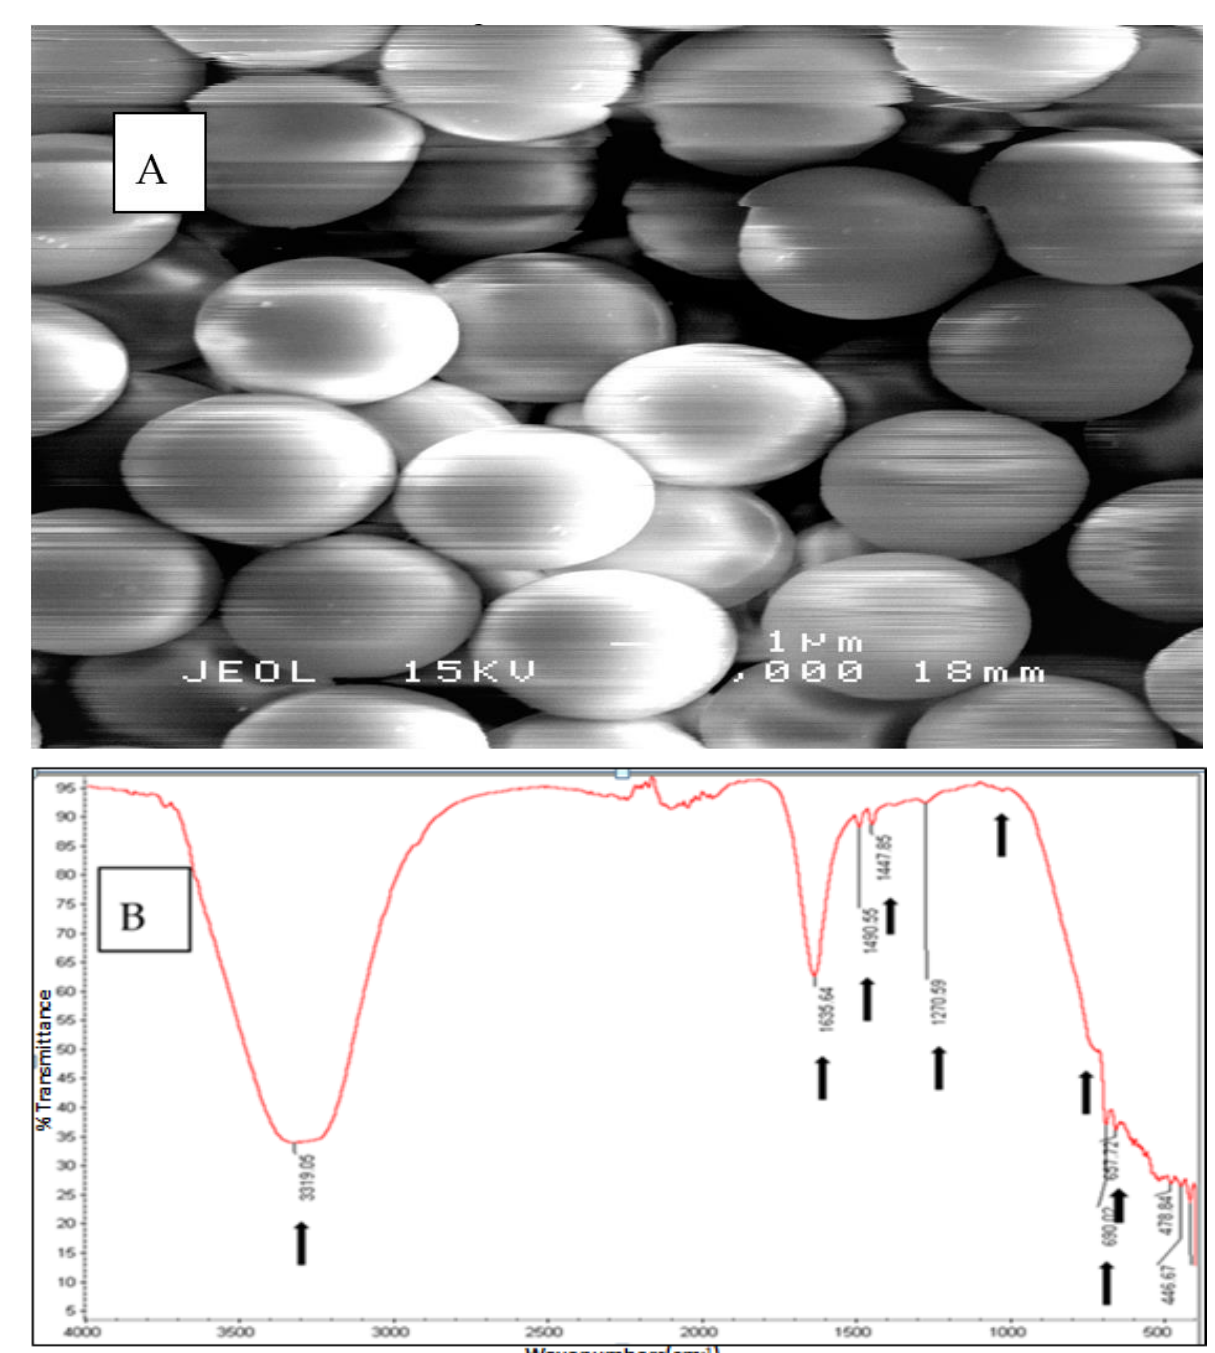
Figure 1. ( A ) SEM image of PS-MPs (0.5 µm) and ( B ) FTIR spectrum of polystyrene microplastics beads used in this study.